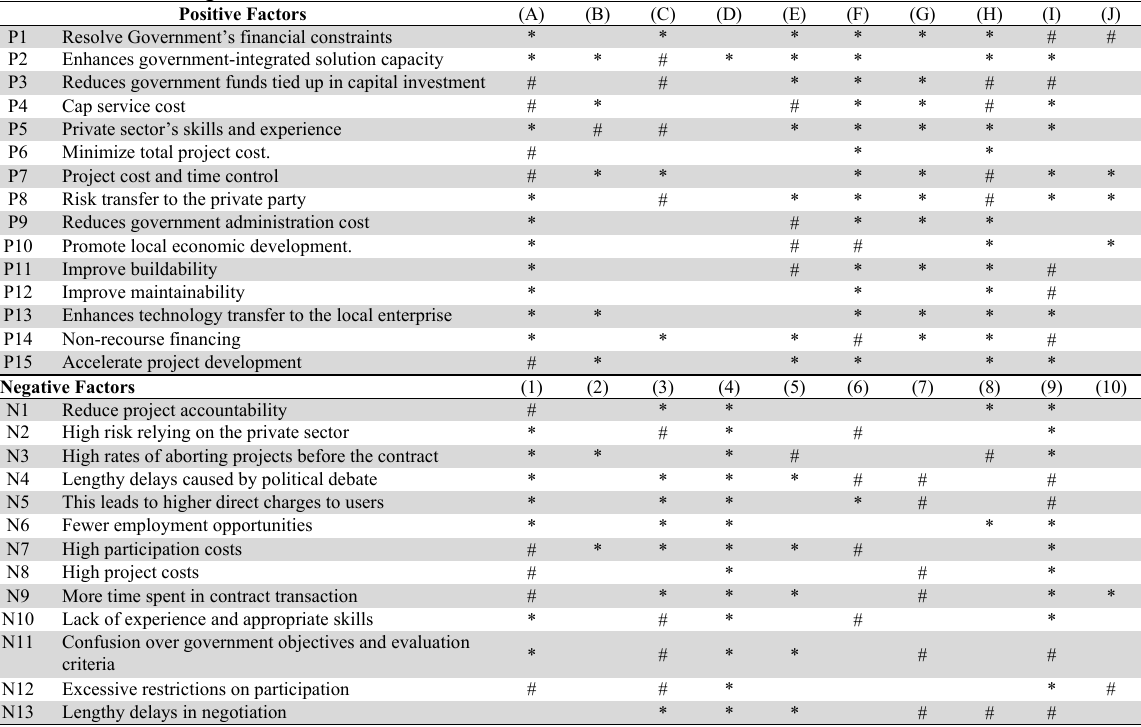
List of Positive and Negative